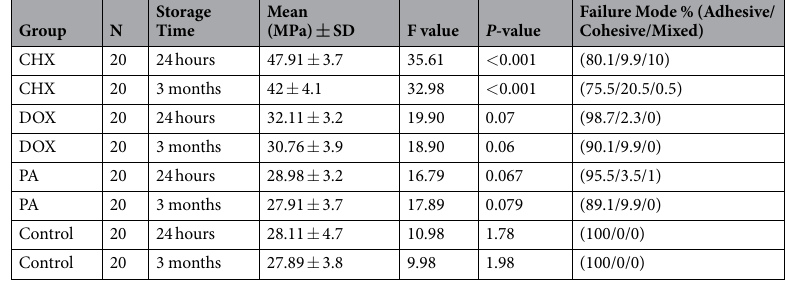
Table 2. Tensile bond strength (MPa), Failure rate and Mode of